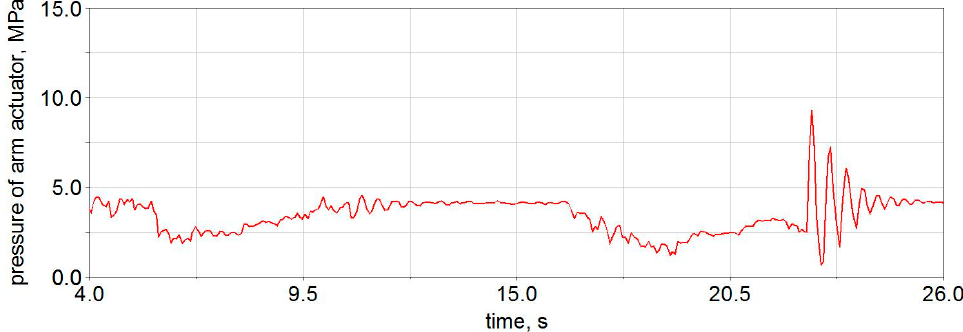
Figure 15. Plot of arm cylinder pressure for manipulator without counterbalance valves and effector velocity 300 mm/s.